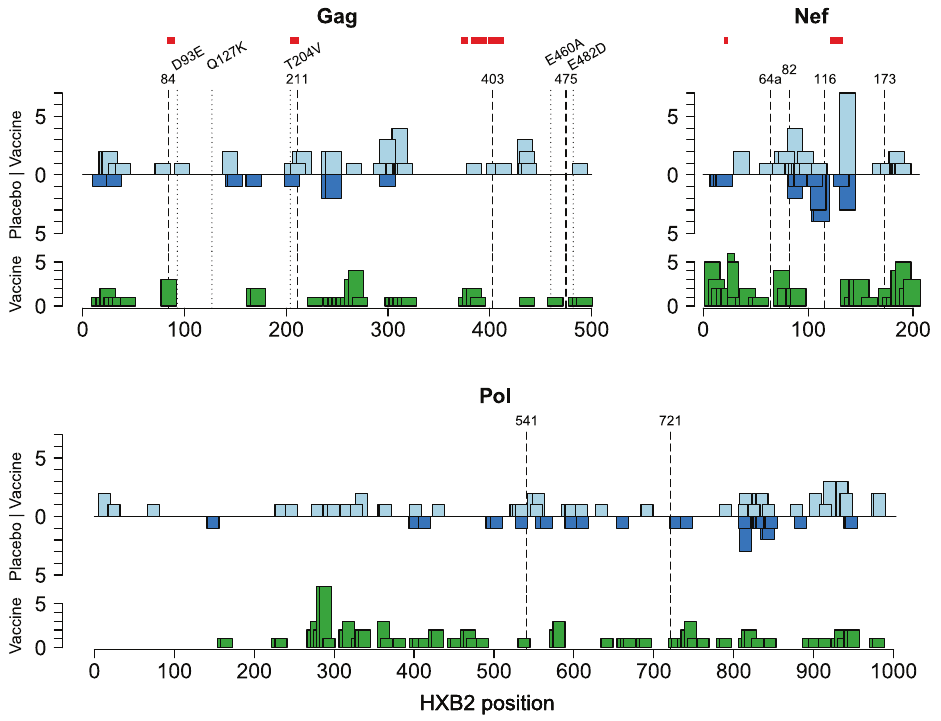
Figure 4. Signature Sites in Relation to T-Cell Responses. Locations of the signature sites and pre- and post-infection T-cell responses for Gag, Nef, and Pol. For each protein, the top graph represents the location of post-infection IFN c ELISpot responses detected in 19 vaccine and 11 placebo recipients (light and medium blue columns, respectively), signature K-mers (red horizontal bars), amino acid signature sites (dashed vertical lines), and sites where an insert-mismatch was found to be associated with viral load in the vaccine group alone (dotted vertical lines; Materials S1 Section 5). The bottom graph corresponds to pre-infection IFN c ELISpot responses detected in 27 vaccine recipients (green columns). The region covered by each responsive peptide is indicated by the box width, and the number of subjects reacting to that peptide is indicated by the box height.